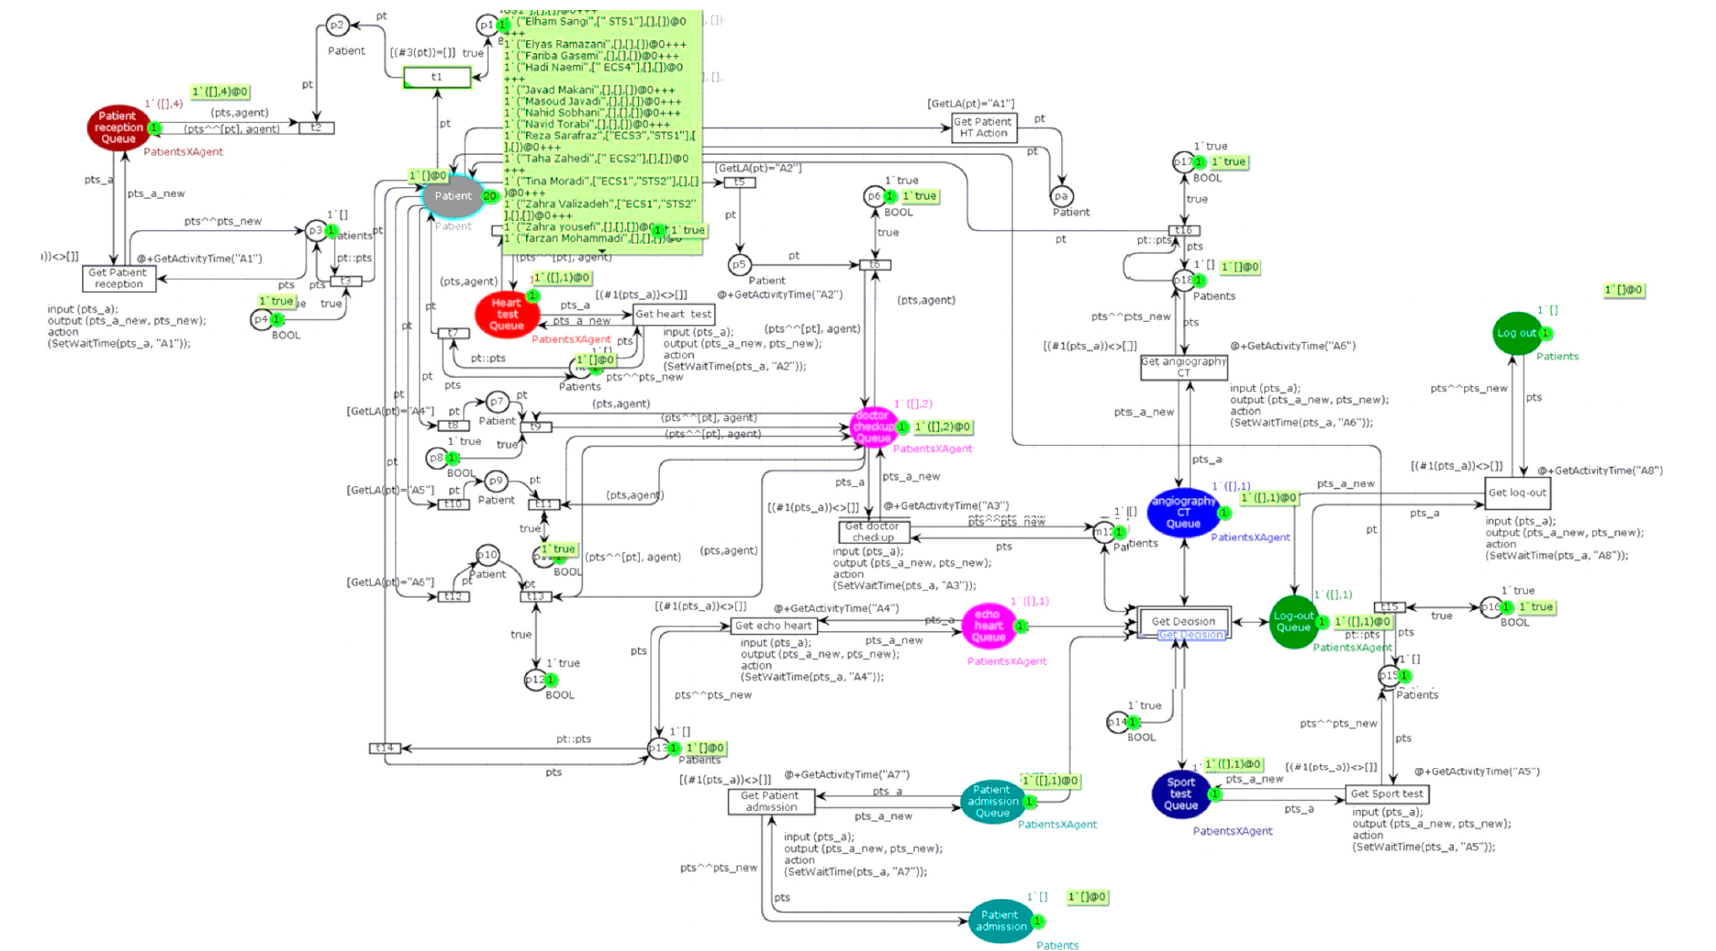
Figure 6. The Petri model of patient’s workflow.